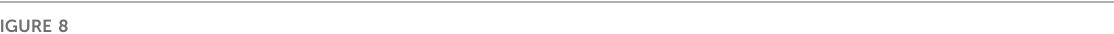
FIGURE 8 respectively. Repetitive fi ring was induced by current ramp combined with white noise (D1) and the fi rst 12 spikes were averaged from the fi rings recorded with NaT + CF (D2&D3), K(DR)+CF (D4&D5) , NaP + CF (D6&D7) and CaL + CF (D8&D9) , respectively. The averaged spikes and averaged ionic currents were shown in the right insets (red traces). More spikes were generated and bigger inward currents were induced by WN + CF. (E) Statistical results showed that Control + CF (NaT) increased NaT currents by 0.2 nA compared with control (NaT) without CF. WN increased NaT currents by 0.3 nA compared with control. WN + CF (NaT) increased NaT currents by 0.6 nA compared with control (E1) . Control + CF (K(DR)), WN, and WN + CF (K(DR)) did not change K(DR) currents signi fi cantly (E2) . Control + CF (NaP), WN, and WN + CF (NaP) substantially increased the NaP currents (E3) . Similar to NaP + CF, Control + CF (CaL), WN, and WN + CF (CaL) also signi fi cantly increased CaL currents (E4) . Data are expressed as mean ± SD. Unpaired T-tests was performed. * p < 0.05.